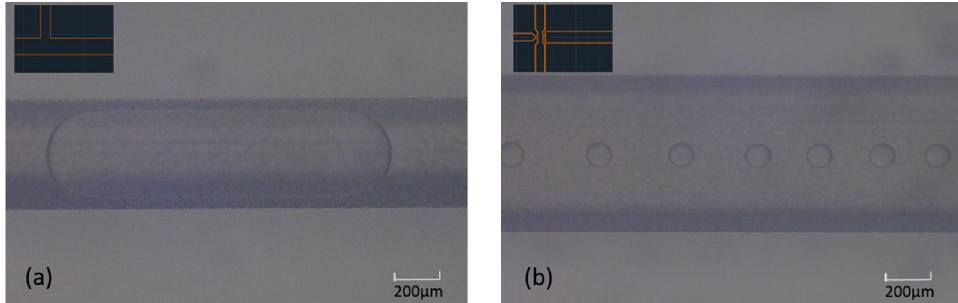
Figure 2. ( a ) Ellipsoidal microdroplet in a microfluidic channel/slug flow. ( b ) Spherical microdroplets in a microfluidic channel/droplet flow. The microfluidic device architectures used to achieve these flow patterns are shown in the inserts and discussed in detail below.